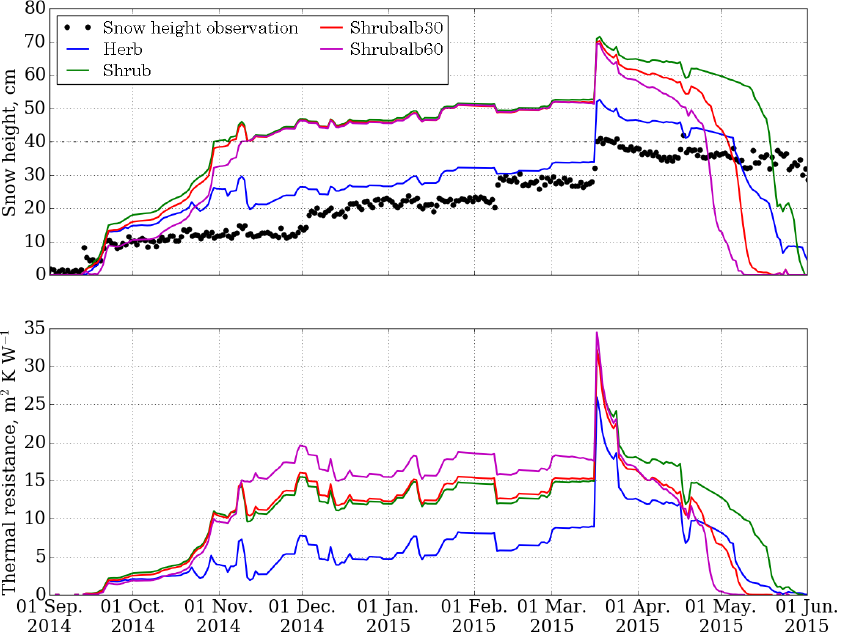
Figure 8. Simulation of the evolution of snow height (top) and snowpack thermal resistance (bottom) with the herb , shrub , shrubalb30 and shrubalb60 scenarios, for the 2014–2015 winter. Snow height monitored with an ultrasound snow gauge is also